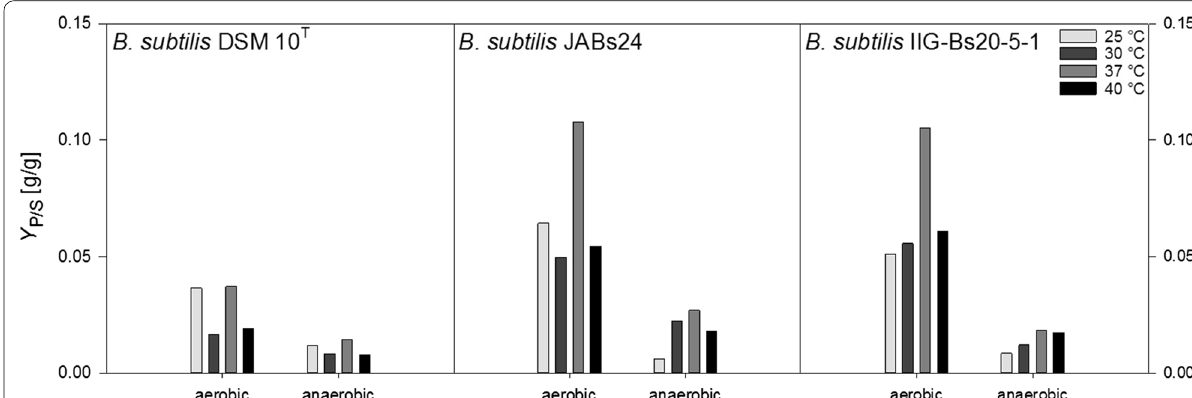
Fig. 4 Overview of the calculated product yields on substrate Y P/S (g/g) for strains B. subtilis DSM 10 T , B. subtilis JABs24 and B. subtilis IIG-Bs20-5-1 under aerobic and anaerobic conditions at 25 °C, 30 °C, 37 °C and 40 °C